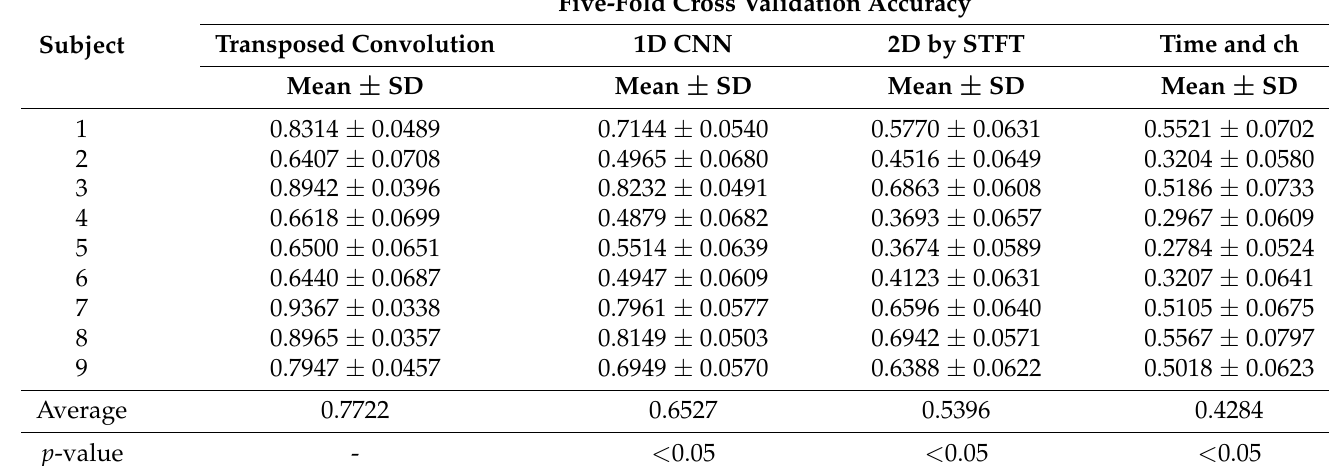
Table 5. Cross-validation accuracy.